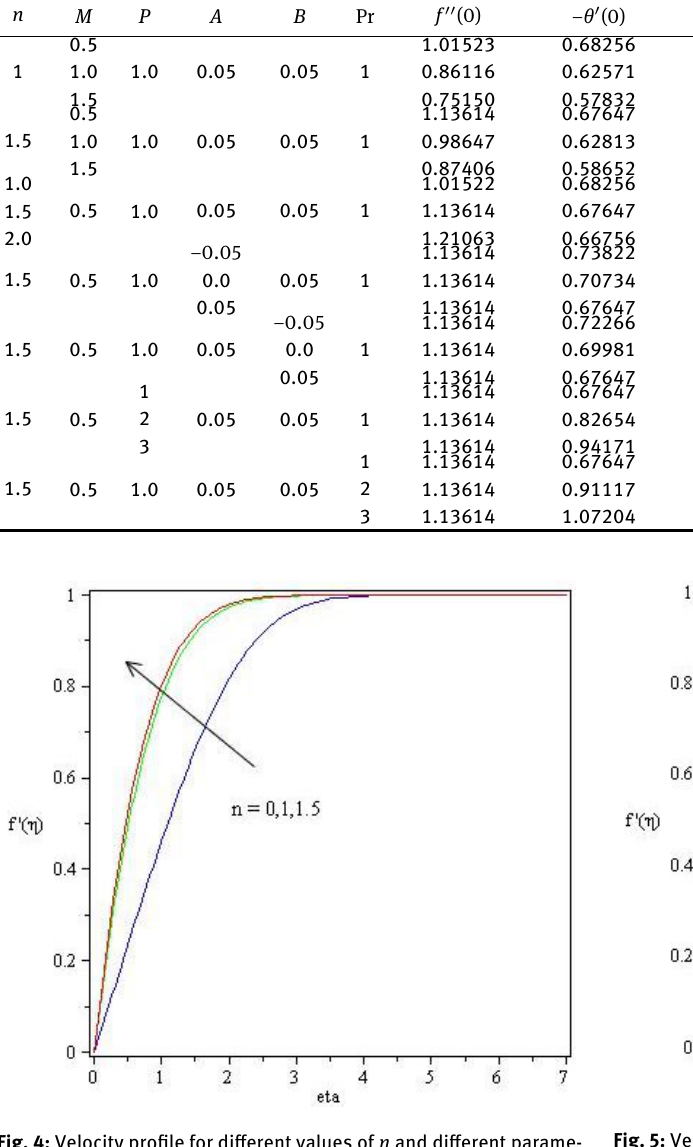
Fig. 4: Velocity profile for different values of n and different parame- ter p = 1, pr = 1, M = 0, A = −0.05, B = −0.05